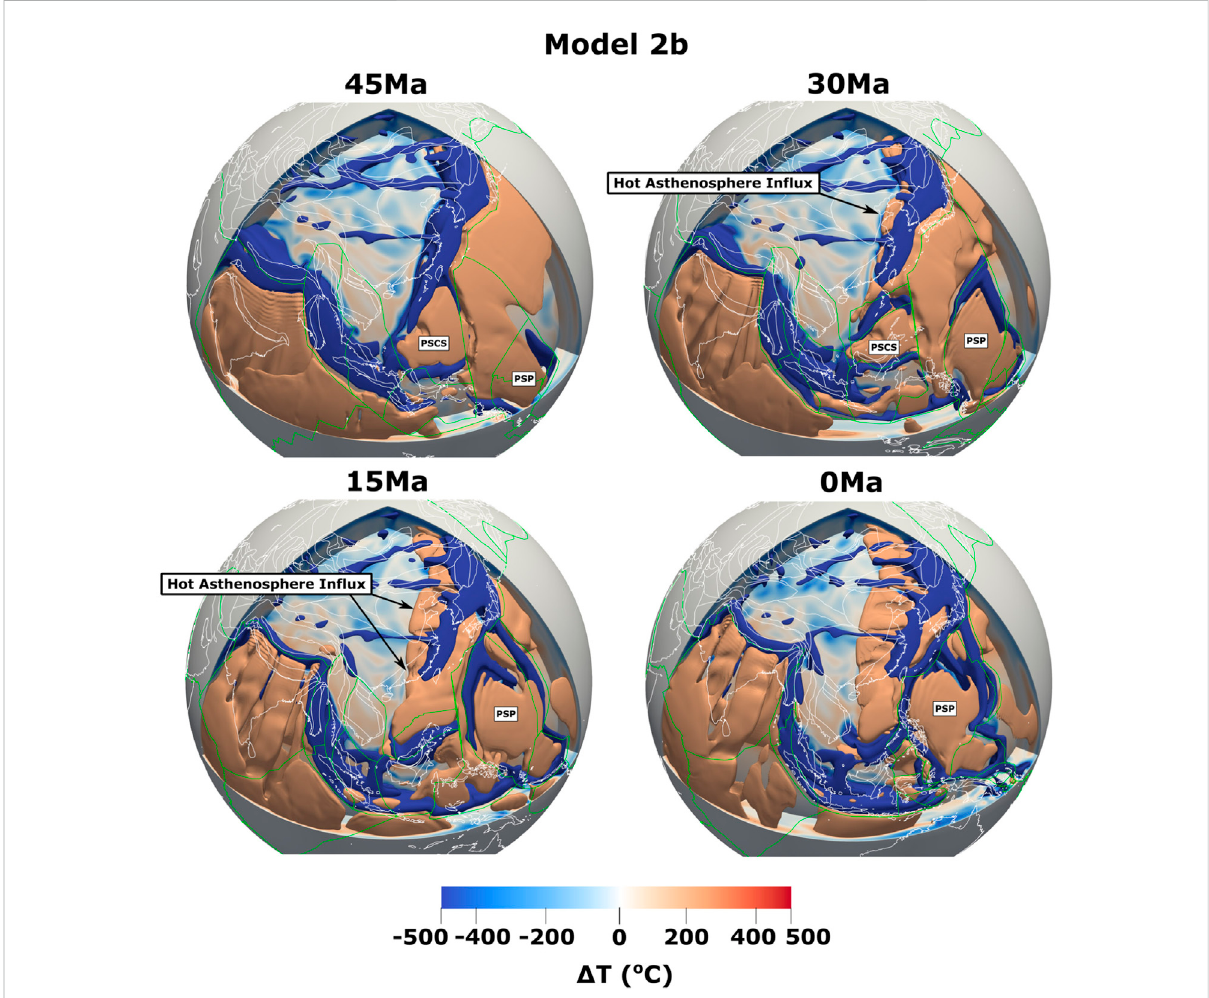
FIGURE 4 Foursnapshotsat45,30,15,and0 Mafromtheuppermantle fl owhistoryofourpreferredModel2b(Linetal.,2020)showingtheCenozoicin fl